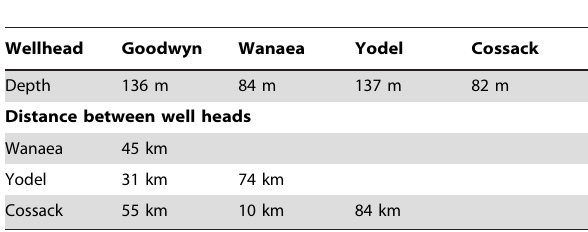
Table 1. Depths (metres) and distance (kilometres) between the